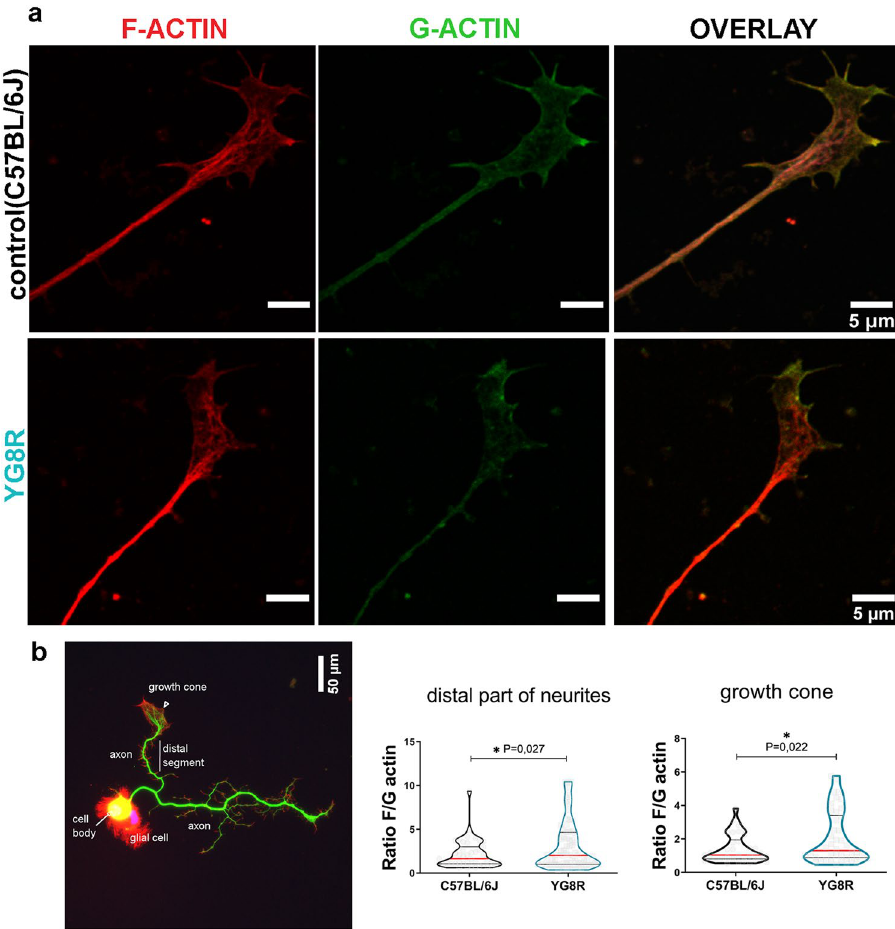
Figure 2. Growth cones of frataxin-deficient neurons of YG8R mice contain high levels of F- and G-actin. ( a ) Representative images of growth cones of sensory neurons from dorsal root ganglia (DRG) stained with the phalloidin-TRITC and Deoxyribonuclease I probes to detect endogenous levels of F actin (red) and G-actin (green) respectively. Confocal images show the maximal intensity projection. Merge of images show colocalization regions of F- and G-actin, as well as the differences in the expression and distribution of F/G- actin in growth cones. Scale bars 5 µ m. The F/G-actin ratio was quantified for the distal segment (most distal part of neurites) and growth cones ( b ). The image illustrates the three major compartments (cell body, neurites and growth cones) of a growing-adult DRG neuron (24 hours in culture). Rhodamine, anti- β -Tubulin III and DAPI were used to detect F-actin (red), microtubules (green) and nuclei (blue). A white line surrounds the distal segment that has been used in the study to analyse the levels of F- and G-actin. The ratio was significantly increased in the distal segment (b, middle) and the growth cones (b, right) of YG8R mice compared to the controls (C57BL/6J). Violin plot shows the distribution of the values for the ratio in both genotypes. Red horizontal bars indicate the median, black horizontal bars indicate quartiles and grey dots shows the values. Welch’s t-test was used to analyse significant changes between genotypes: * P ≤